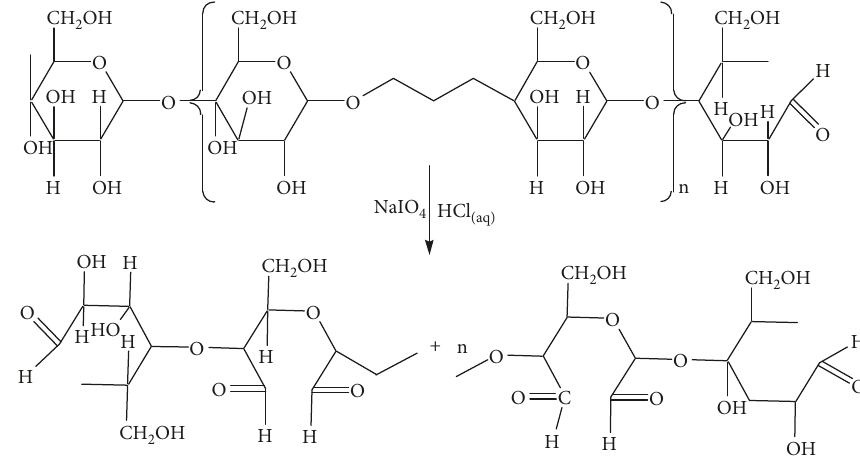
Scheme 10: Reaction of acid hydrolysis and oxidation of starch.